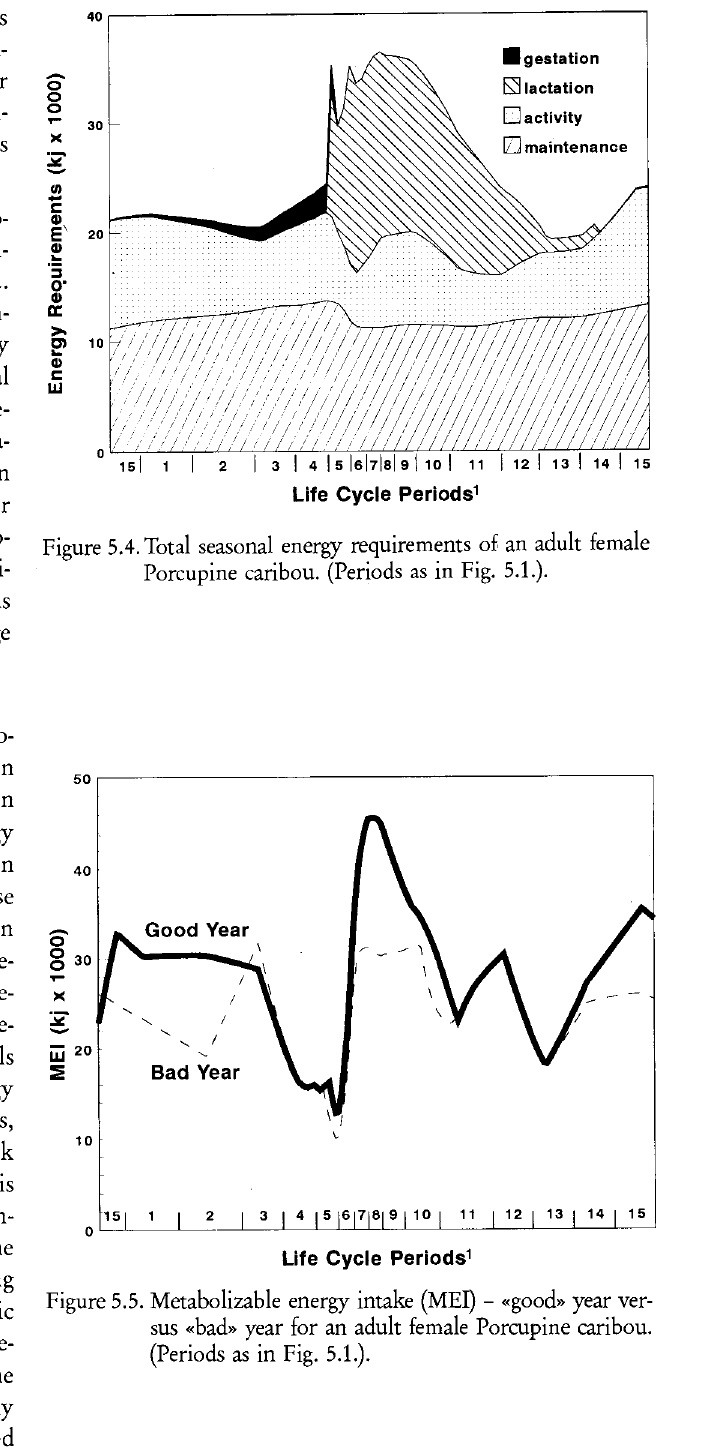
Figure 5.5. Metabolizable energy intake (MEI) - «good» year ver sus «bad» year for an adult female Porcupine caribou. (Periods as in Fig.